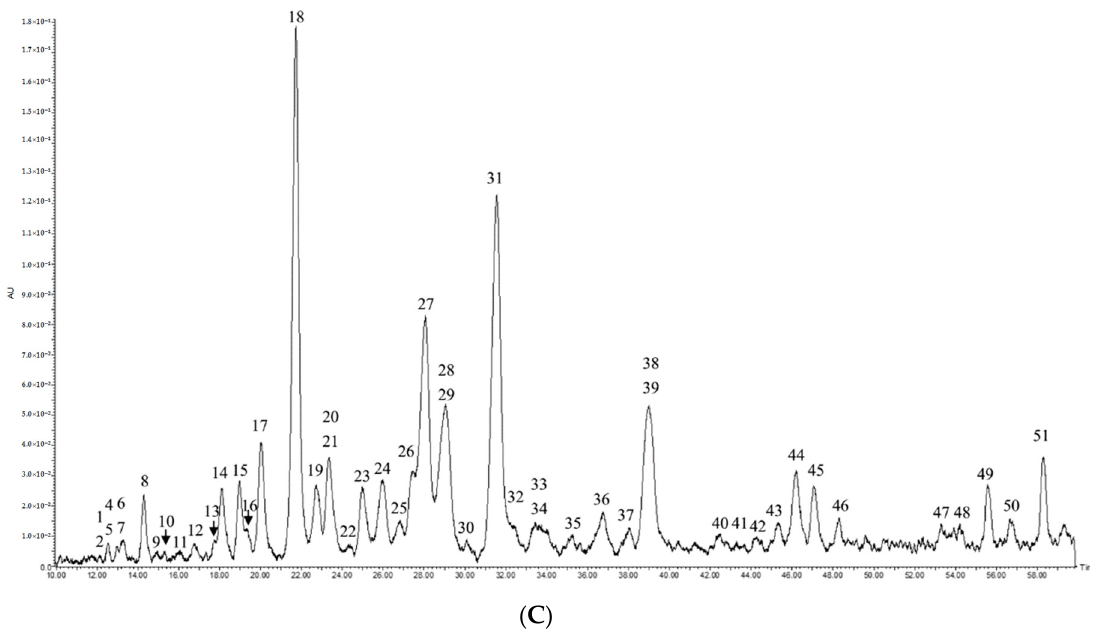
Figure 1. Saponins from the seeds of Camellia sinensis detected by ultra-high-performance liquid chromatography coupled with photo-diode array detector and quadrupole time-of-flight mass spectrometry (UPLC-PDA-QTOF-MS). ( A ) UPLC/MS total ion chromatogram of the crude extract of C. sinensis seeds (2.0 mg/mL) in negative ion mode. ( B ) UPLC-PDA chromatogram of the crude extract of C. sinensis seeds (2.0 mg/mL) at 210 nm. ( C ) UPLC-PDA chromatogram of the total saponin fraction of C. sinensis seeds (2.0 mg/mL) at 210 nm.